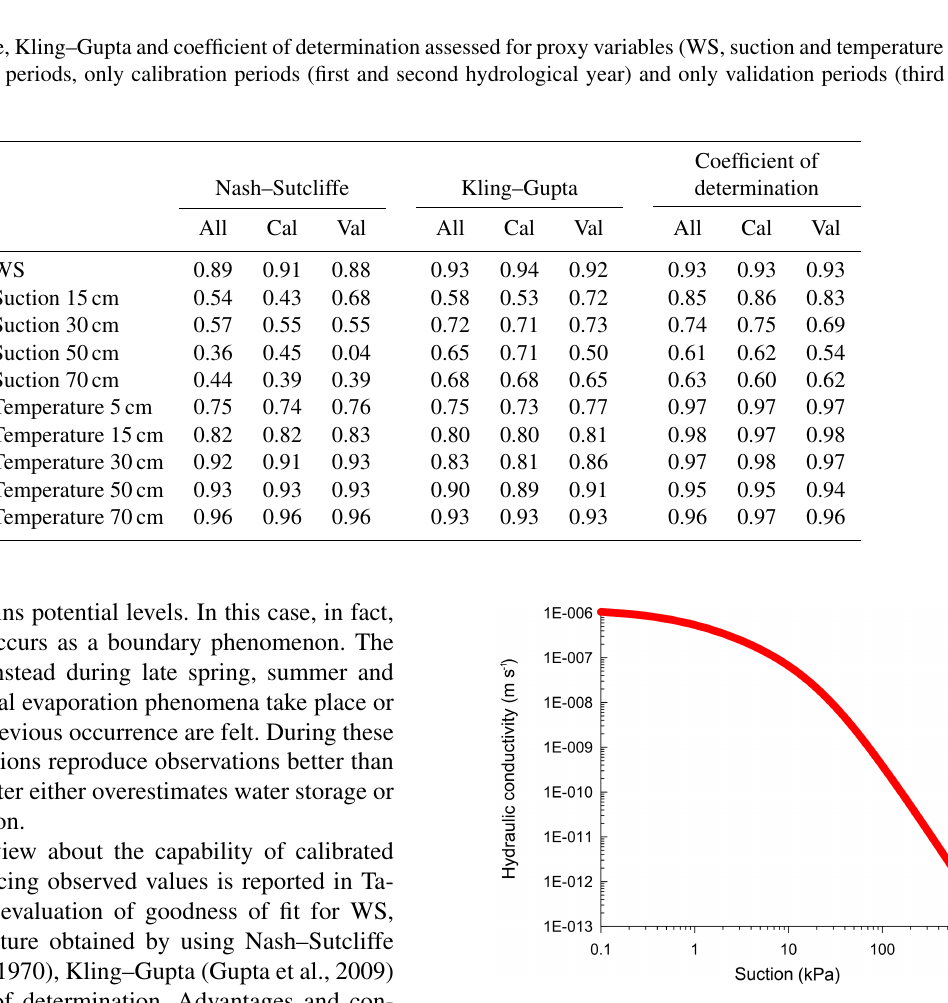
Figure 11. The hydraulic conductivity function obtained from the IEM back analysis of the hydrological